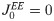
The two mechanisms for asynchronous chaos in the two-population rate model with threshold-linear transfer function.Simulations were performed for N
E = N
I = 8000, K = 400, I
E = I
I = 1, J0EE=0, J0EI=0.8. A: II mechanism for J0II=6, J0IE=10. Left panels: Examples of traces of excitatory (h
IE) and inhibitory inputs (h
EI, h
II) into one neuron. Right: PAC of the net inputs to the E neurons. Gray: τ
IE = τ
EI = τ
II = 10 ms; Black: τ
IE = 100 ms, τ
EI = τ
II = 10 ms; Blue: τ
II = 100 ms, τ
IE = τ
EI = 10 ms; Purple: τ
II = 1 ms, τ
EI = τ
IE = 10 ms. Inset: All PACs plotted vs. τ/τ
II. B: EIE mechanism for J0II=1, J0IE=15. Other parameters are as in A. Inset: All PACs plotted vs. τ/τ
IE.